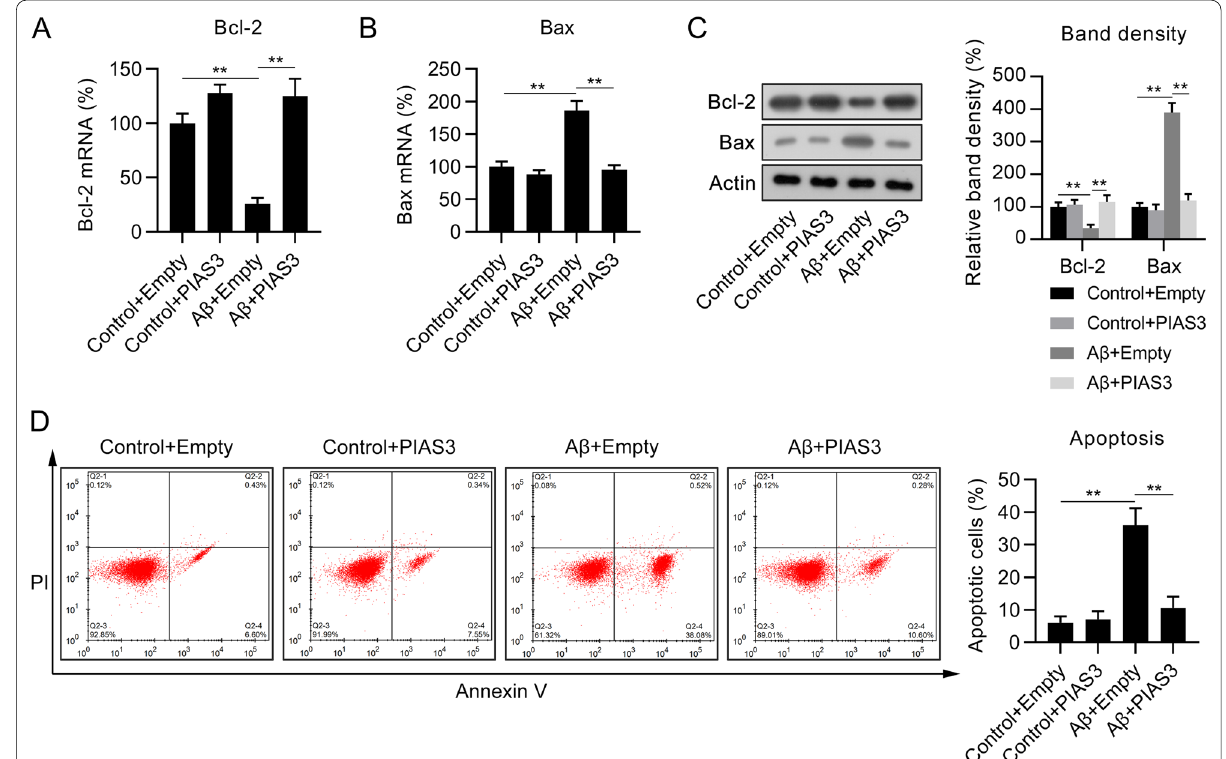
Fig. 3 Effects of PIAS3 overexpression on the apoptosis of Aβ-treated SH-SY5Y cells. Cells were subjected to transfection with a PIAS3 overexpression vector or an empty vector for 1 d, and subsequently subjected to Aβ treatment (20 μM in 0.1% DMSO) for an additional 1.5 d. A – C qPCR and WB were used for determining Bcl-2 and Bax mRNA and protein expression levels. D The number of apoptotic cells was determined using annexin V/PI FC. Data represent mean SEM. **p < 0.01. PIAS3 protein inhibitor of activated STAT3, qPCR quantitative polymerase chain reaction, Aβ ± amyloid beta, WB western blotting, Bcl-2 B-cell lymphoma 2, Bax bcl-2-like protein 4, DMSO dimethyl sulfoxide, FC flow